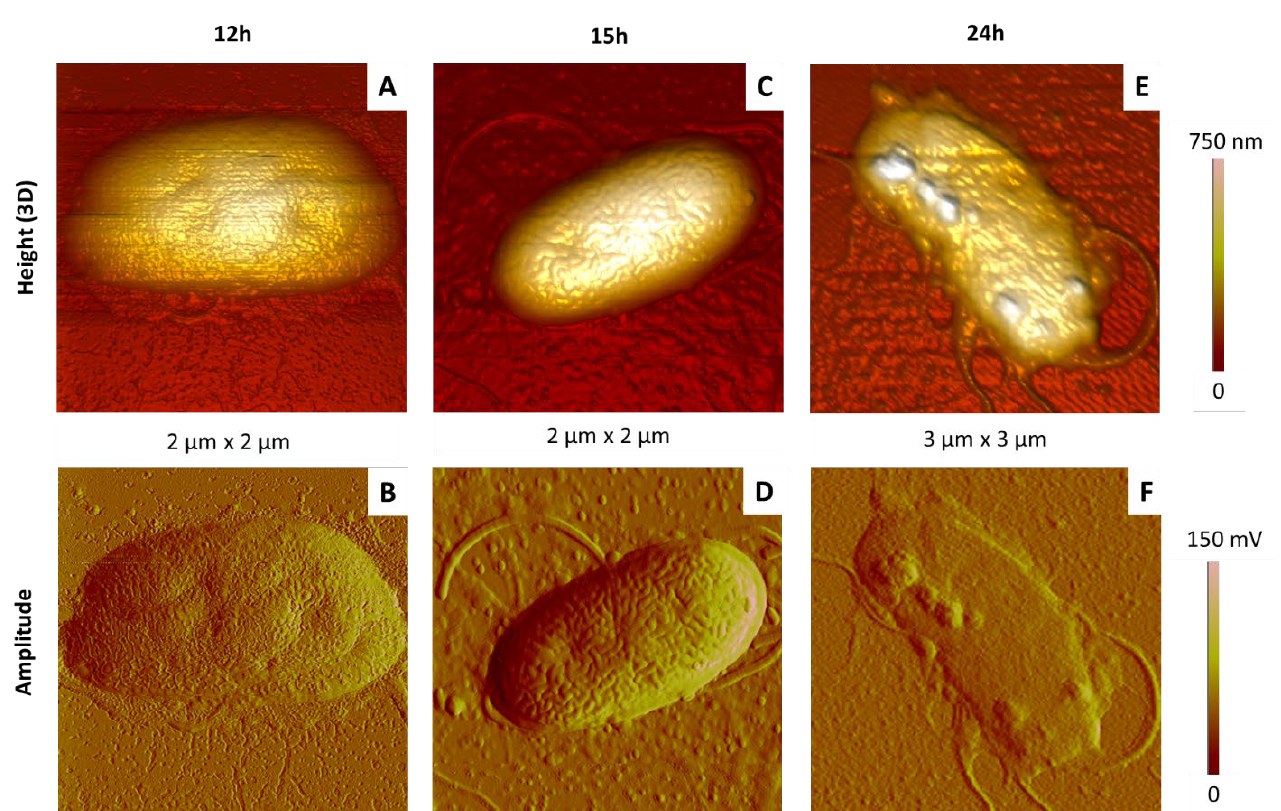
Figure 12. Effect of the culture time on the morphology of isolated P. fluorescens bacteria deposited by simple deposition. The bacteria were cultured in LB medium at 28 °C during different incubation times: 12 h ( A , B ), 15 h ( C , D ) and 24 h ( E , F ). AFM images are 3D height or topographic ones ( A , C , E ) and amplitude ones ( B , D , F ).